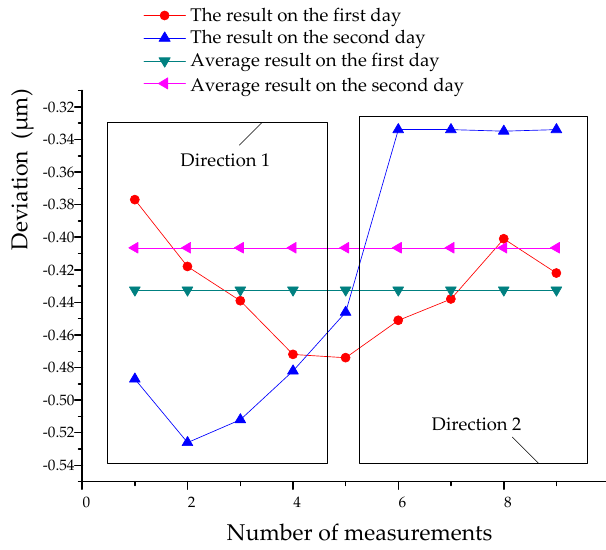
Figure 17. Bidirectional measurement results and the convergence of average result.